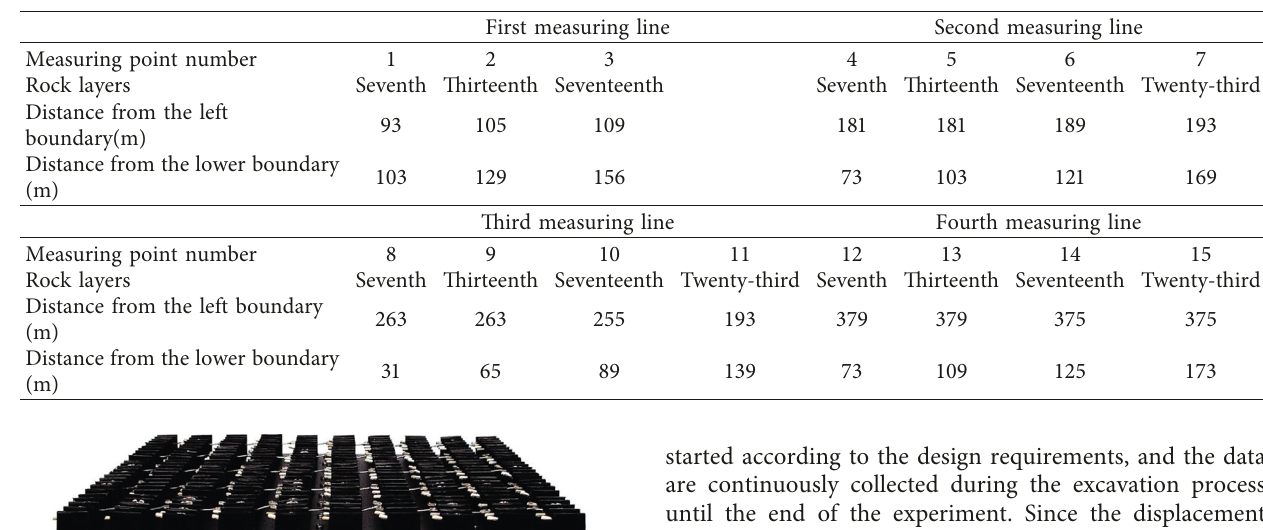
Figure 2: Layout of the displacement sensor. Table 2: Placement of the displacement sensor.